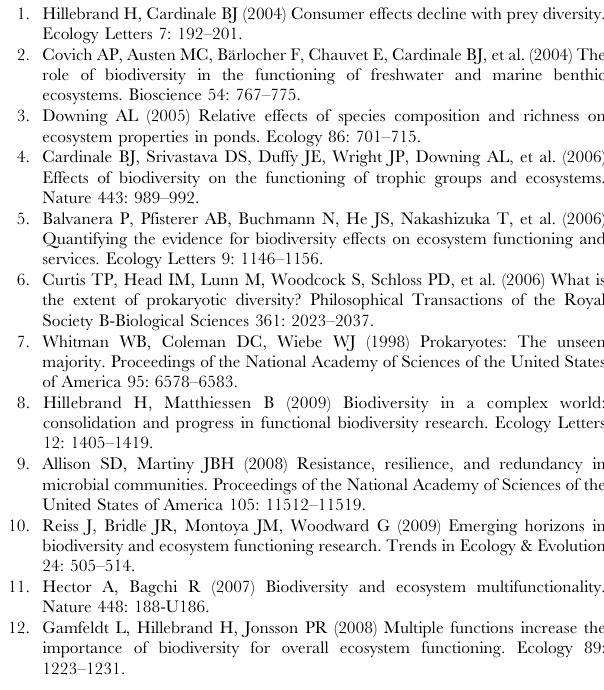
DOC concentration between the start (T0) and end (T10) of the two tests (young and old biofilms) for bioreactors fed with labile and recalcitrant carbon, respectively. Positive values indicate an increase in the fraction of humic compounds relative to the total organic carbon pool. Error bars indicate 6 s.e.m, N= 9. Figure S2 Differences in oxygen concentration in the in- and outflow of the bioreactors. Results are shown for the two test periods, young biofilms (A and B) and old biofilms (C and D). Initial oxygen consumption was greater in bioreactors fed the labile (A and C) compared to bioreactors fed the recalcitrant carbon source (B and D). There were no differences between the high ( e ), medium ( # ) and low ( D ) diversity treatments.